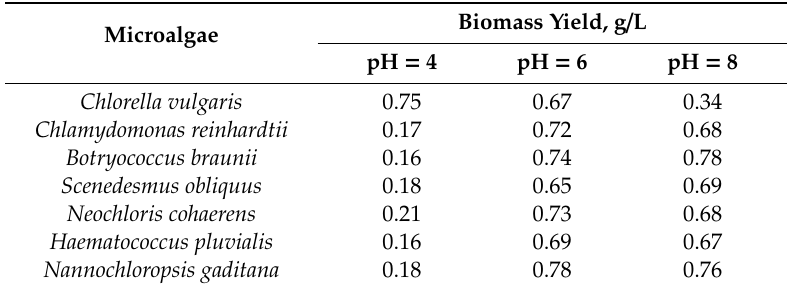
Table 4. The influence of pH on the growth of various microalgae (table reconstructed using data from Varshney et al. [7]).